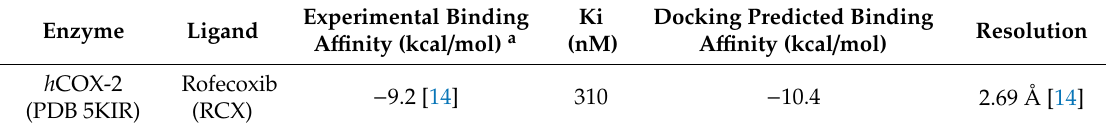
Table 2. Comparison between experimental and theoretical binding affinities.